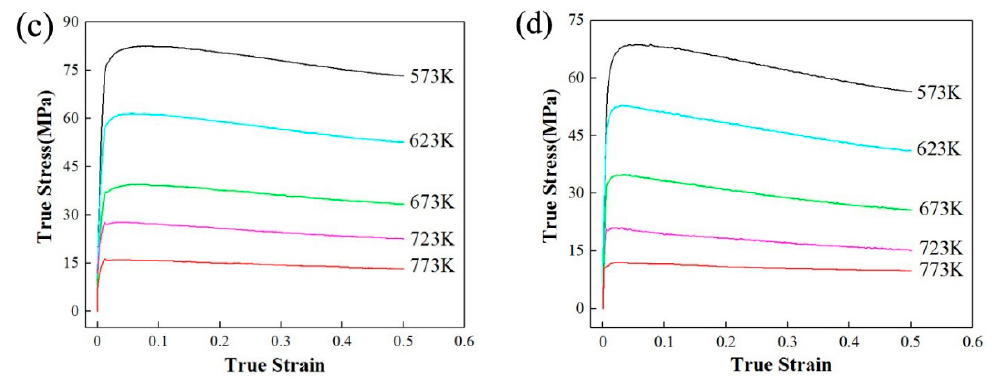
Figure 2. Flow curves of A356 alloys obtained from compression tests: ( a ) 10 0 s − 1 ; ( b ) 10 − 1 s − 1 ; ( c ) 10 − 2 s − 1 ; ( d ) 10 − 3 s − 1 .